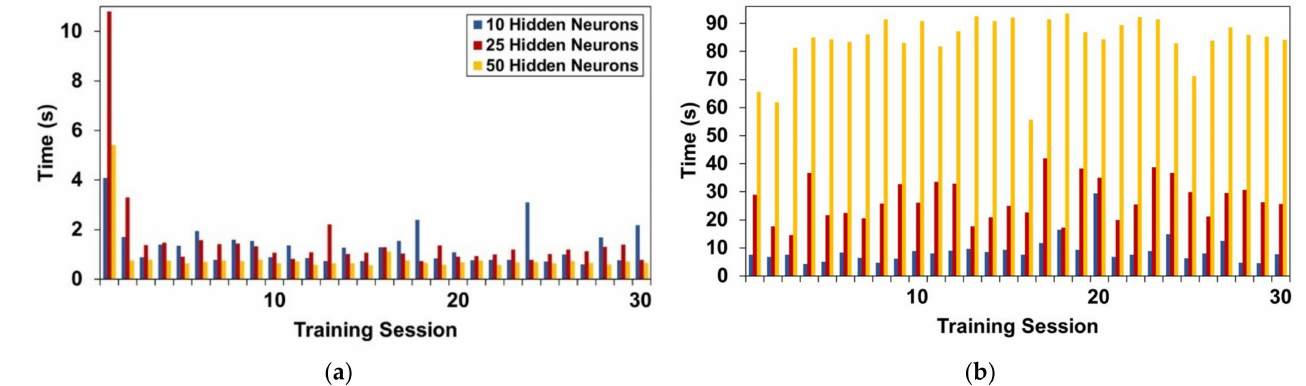
Figure 13. Duration of each training session of FFNN1 for: ( a ) LM training algorithm; ( b ) BR training algorithm.